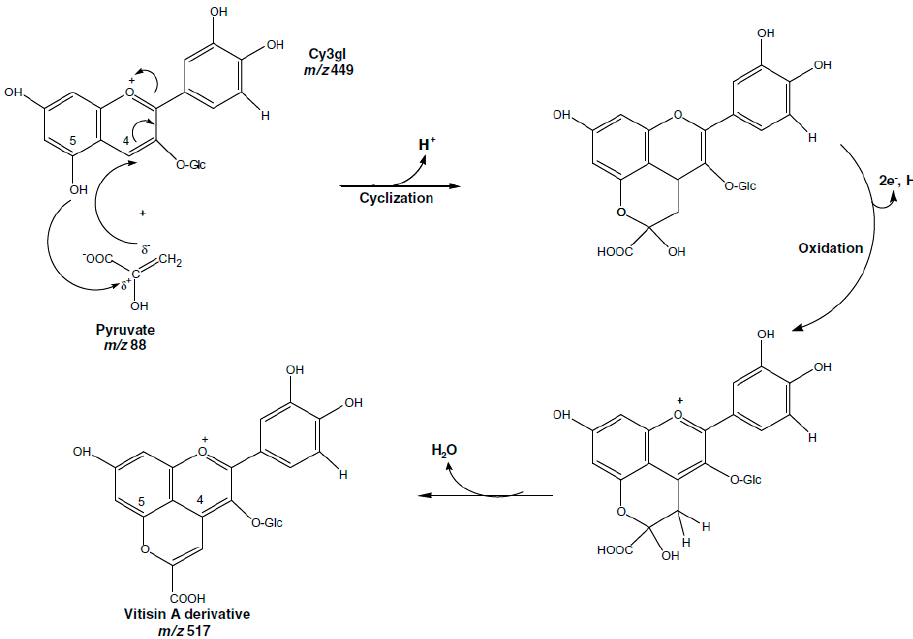
Figure 3. Condensation reaction of cyanidin-3-glucoside and pyruvate at 600 MPa and 70 °C proposed by Corrales et al. [106].